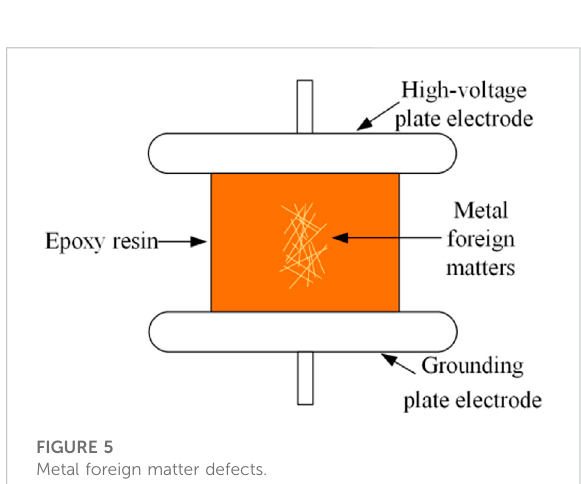
FIGURE 5 Metal foreign matter